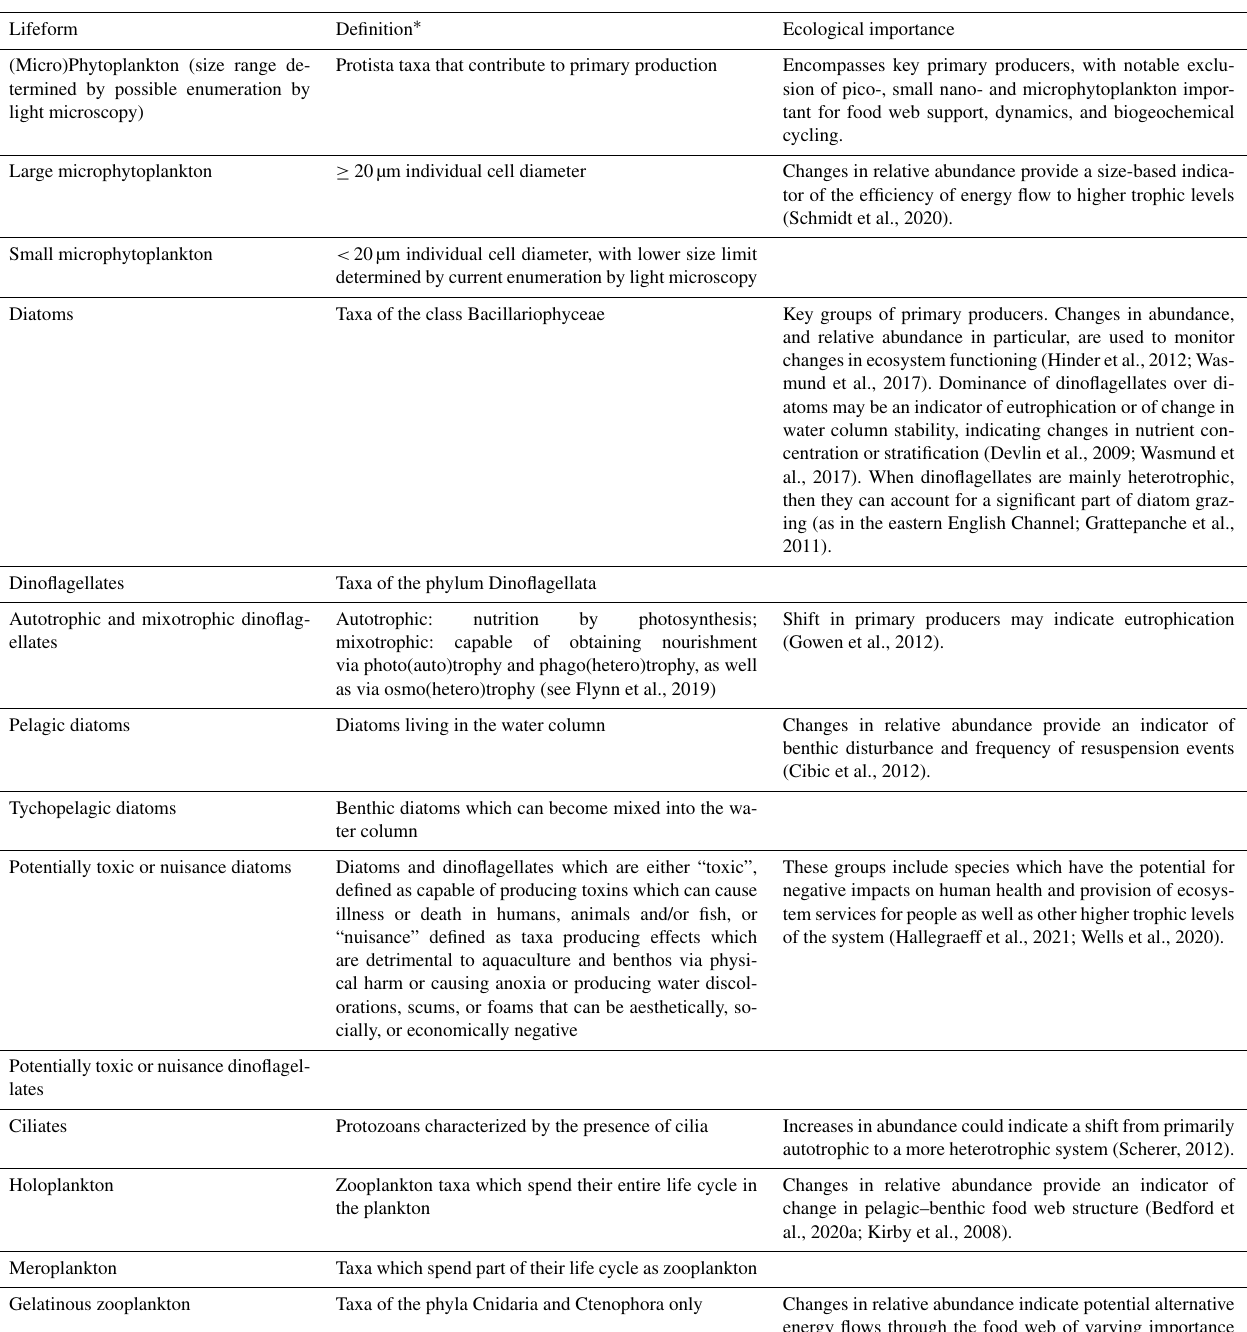
Table 2. List of lifeforms and their ecological importance. The definitions of the lifeforms (see also McQuatters-Gollop et al., 2019) based on the trait look-up table are given in Table